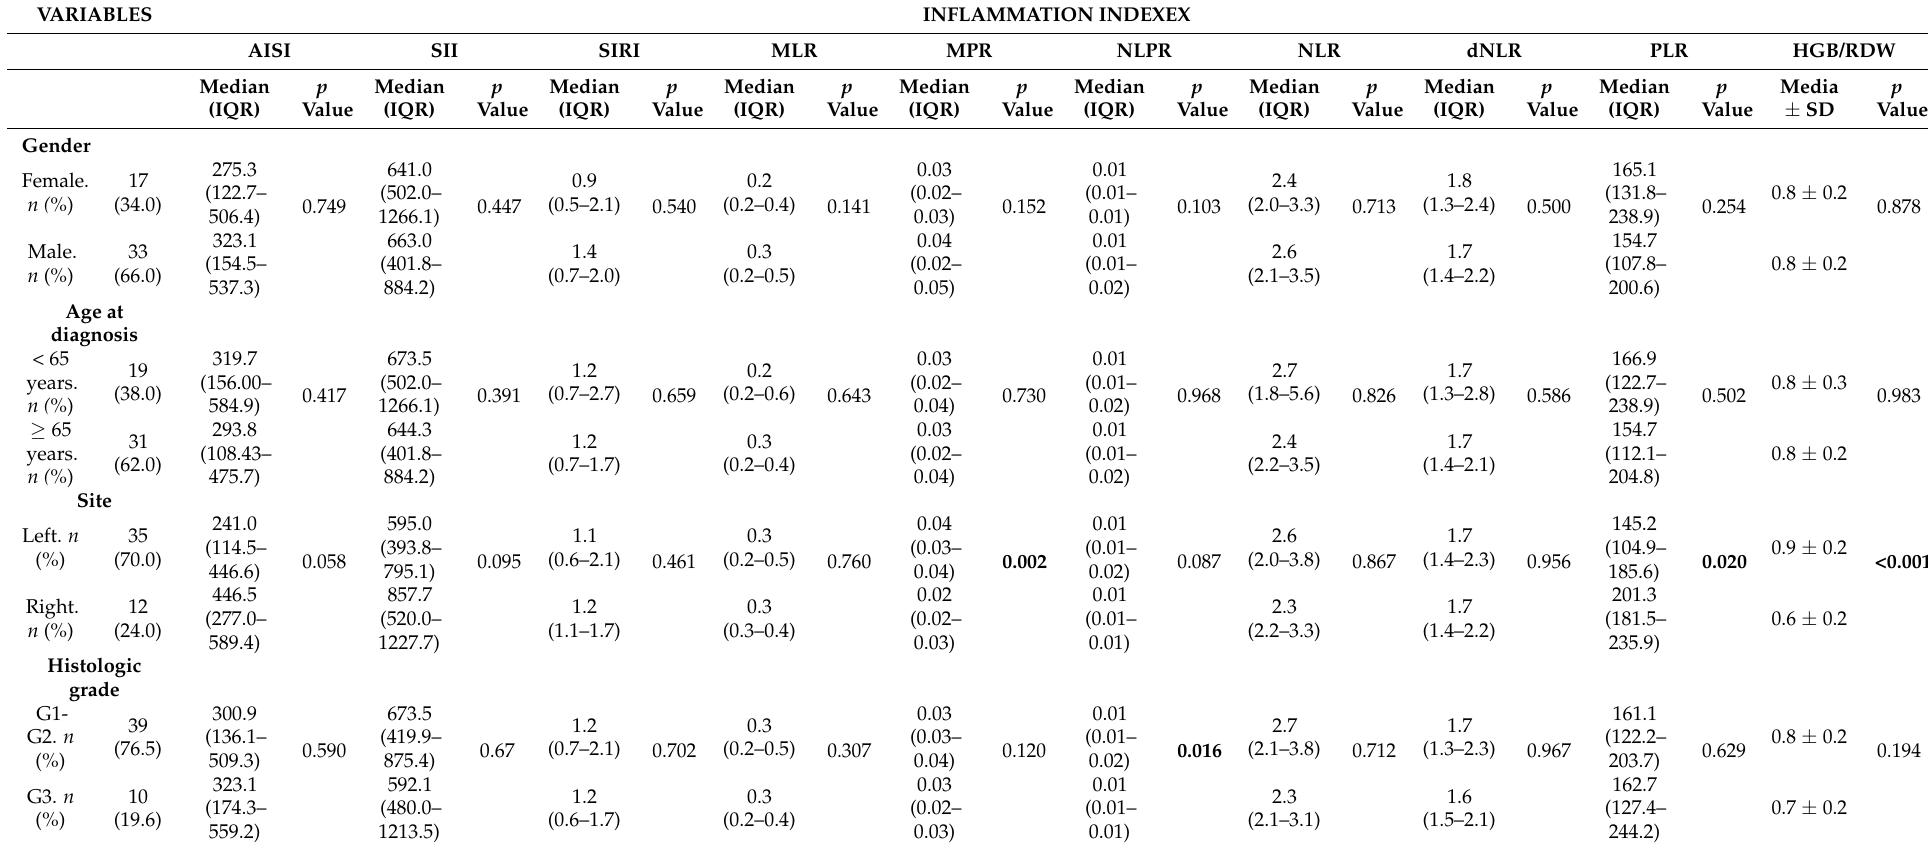
Table 2. Correlation between inflammatory indexes and clinical-pathological features in patients with colorectal